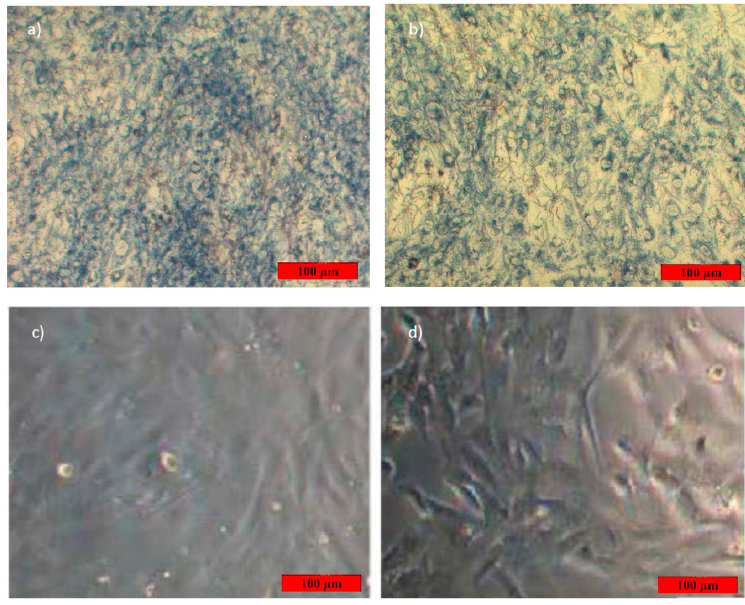
Figure 28. The surface of ( a ) a standard specimen and Ti6Al4V after a 72 h ( b ), 48 h ( c ) and 24 h ( d )